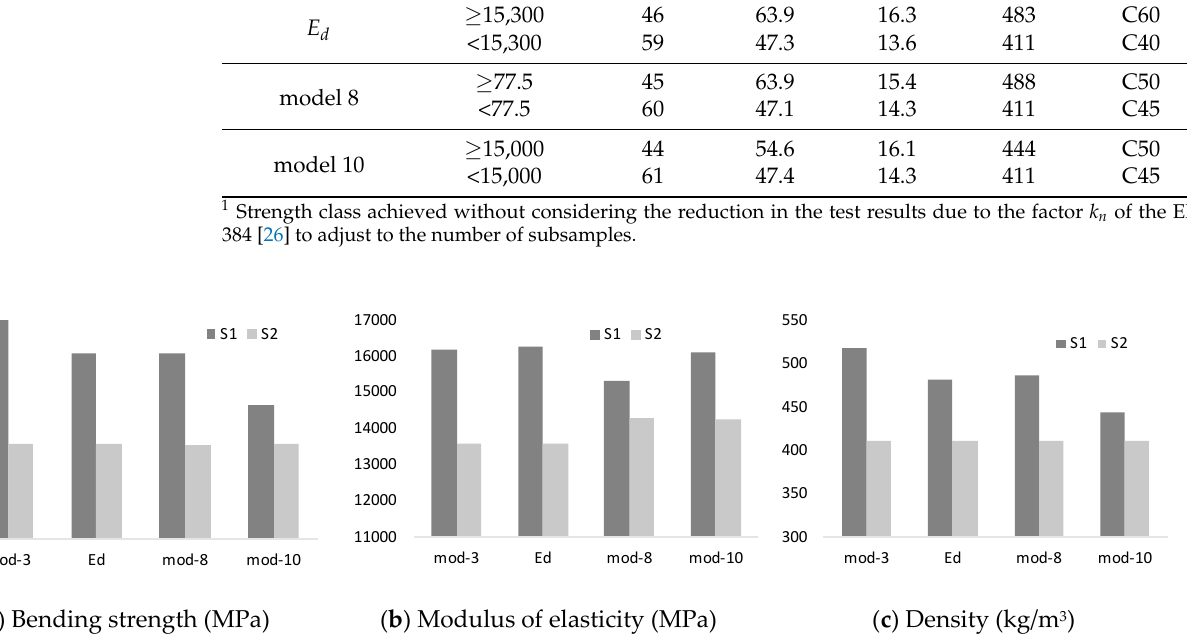
Figure 3. Characteristic values of grade S1 and S2 selected by the grading parameters developed with the regression models described in Table 5 and 6: ( a ) 5th percentile of bending strength; ( b ) mean values of modulus of elasticity; ( c ) 5th percentile of density.